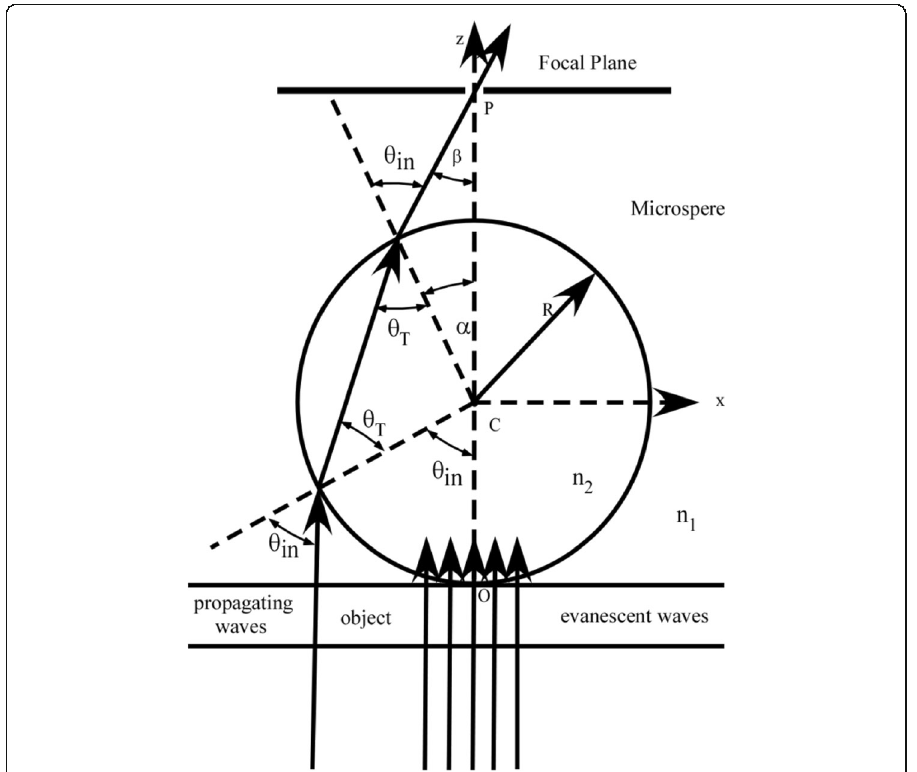
Fig. 1 Plane EM waves are transmitted through the object, converging by the microsphere and exiting through a small circular aperture at point P located on a plane barrier at the focal plane. Evanescent waves which include the information on the fine structures of the object are transmitted into the microsphere near the contact point O and are transformed by the microsphere into propagating waves. The geometric optics trajectory for a propagating ray, which is not evanescent, and which enters the microsphere far from the contact point O is described with the locations of all relevant angles: θ in , θ T , α and β . Bessel beams producing the Nano-jet are obtained by the superposition of the spherical aberration on the geometric optics trajectory. The Nano-jet is modulated by the evanescent waves and the fine structures of the object are obtained by sending the radiation transmitted around point P into a confocal